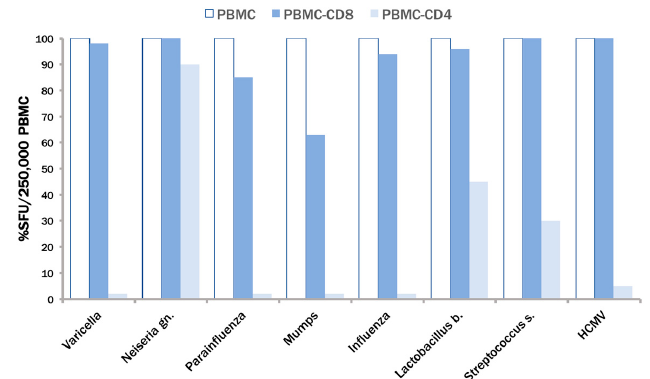
Figure 2. Establishing the CD4/CD8 lineage of responding PBMC. Unseparated PBMC (open bars), PBMC of the same subject that have been depleted of CD8 cells (blue bars), or of CD4 cells (light blue bars) were tested at the same cell number (250,000) per well. The numbers of IFN- γ producing cells were measured by ELISPOT after the addition of the antigens specified on the x-axis. Percent response in the depleted PBMC fractions is shown relative to the unseparated PBMC. Note, for varicella, parainfluenza, mumps and influenza the light blue bars are barely/non visible due to the close to complete abrogation of Spot Forming Units (SFU) formation in CD4 cell-depleted PBMC.